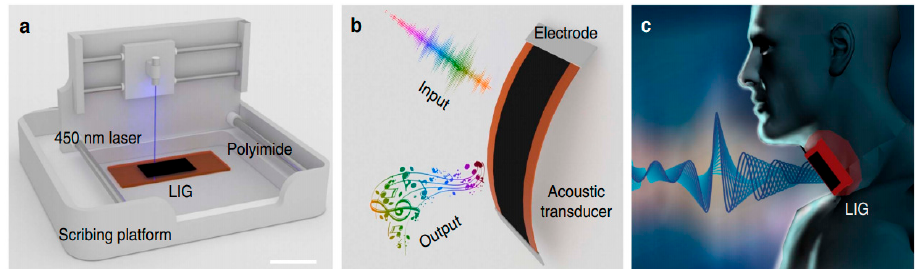
Figure 12. Schematic representation of the manufacturing procedure and the morphology of the LIG sensor. ( a ) The one-step manufacturing process of LIG, ( b ) LIG can produce and sense sound in one device, ( c ) the artificial throat can sense the movement of the throat and produce manageable sound.